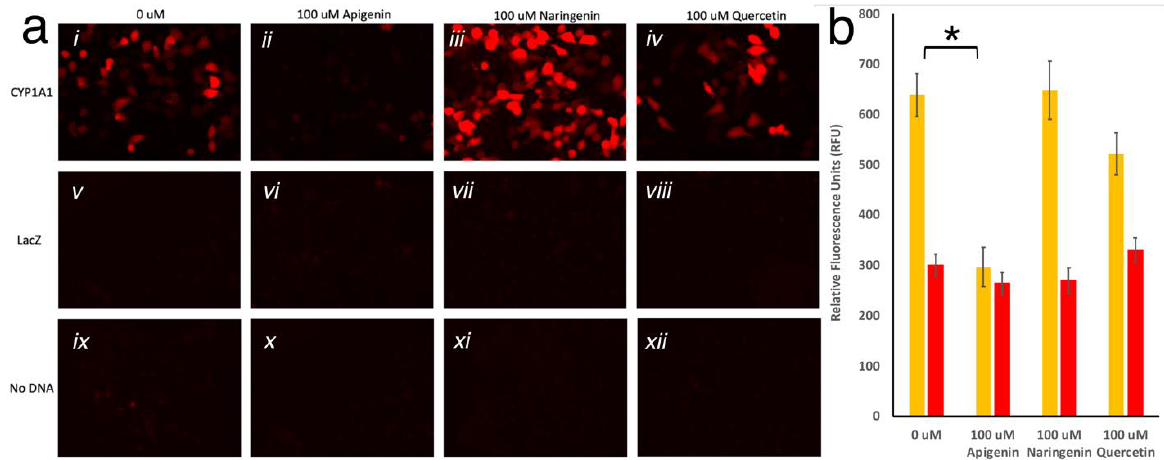
Figure 3. ( a ) HeLa cells imaged with TRITC filter. Twenty-four hours post-transfection with CYP1A1 prom ::mScarlet, LacZ, or no DNA, cells were treated with 0uM ( i , v , ix respectively), 100 µ M apigenin ( ii , vi , x respectively), 100 µ M naringenin ( iii , vii , xi respectively), or 100 µ M quercetin ( iv , viii , xii respectively) for twenty-four hours, washed, and imaged. ( b ) Fluorescence (Ex 560; Em 593) measured in HeLa cells transfected with CYP1A1 prom ::mScarlet or No DNA, treated with 0 µ M, 100 µ M apigenin, 100 µ M naringenin, or 100 µ M quercetin. Each bar represents an average of n = 3. Yellow bars show significant reduction in the average ( ± SD) fluorescence in the presence of apigenin, but not in other conditions, to the fluorescent level of untransfected cells (red bars; * represents p < 0.01).